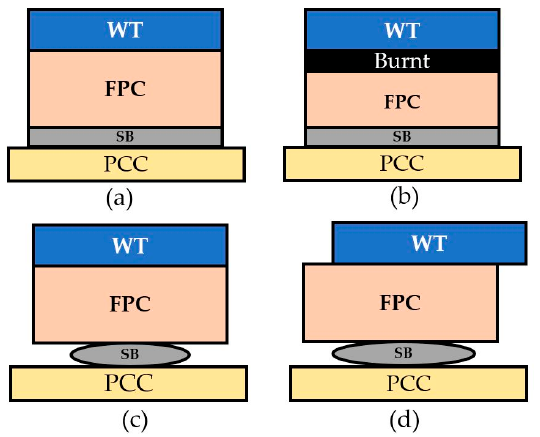
Figure 2. The RSP mechanism.